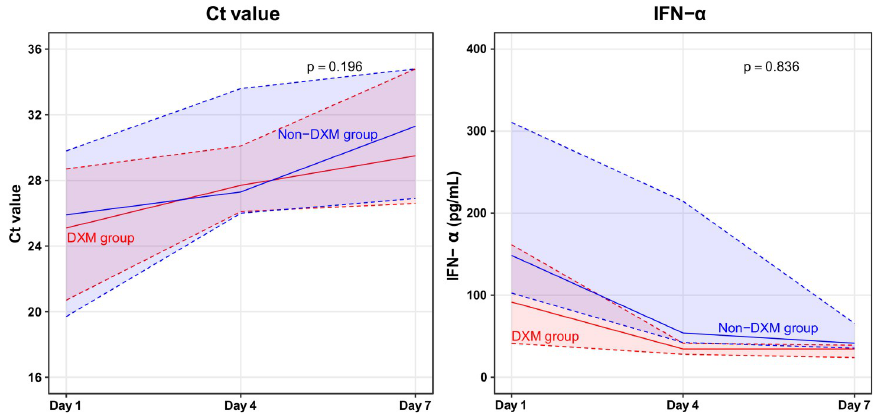
Fig 5. Severe acute respiratory syndrome coronavirus 2 load and type I interferon response during the 7-day study period. Solid lines represent the median values and the shaded areas bordered by dotted lines represent the upper and lower quartiles. Ct, cycle threshold; DXM, dexamethasone; IFN- α , interferon- α .